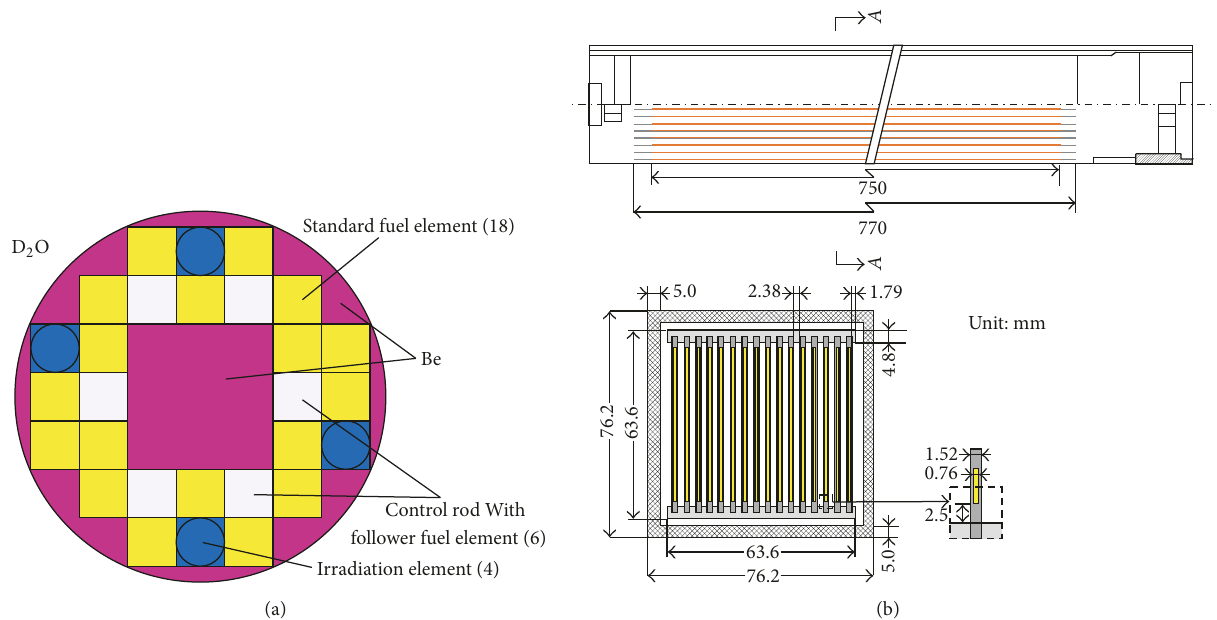
Figure 1: HFRR core configuration and schematic of follower fuel assembly [9]: (a) fuel element configuration; (b) schematic of the follower fuel